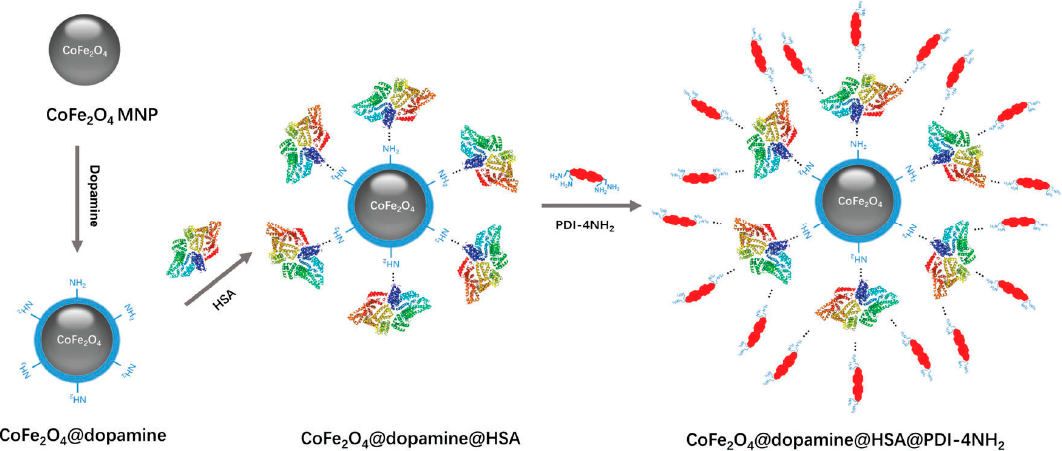
Figure 11. Synthetic procedure for the preparation of fluorescent CoFe 2 O 4 magnetic nanoparticles. Adapted from ref. [76].